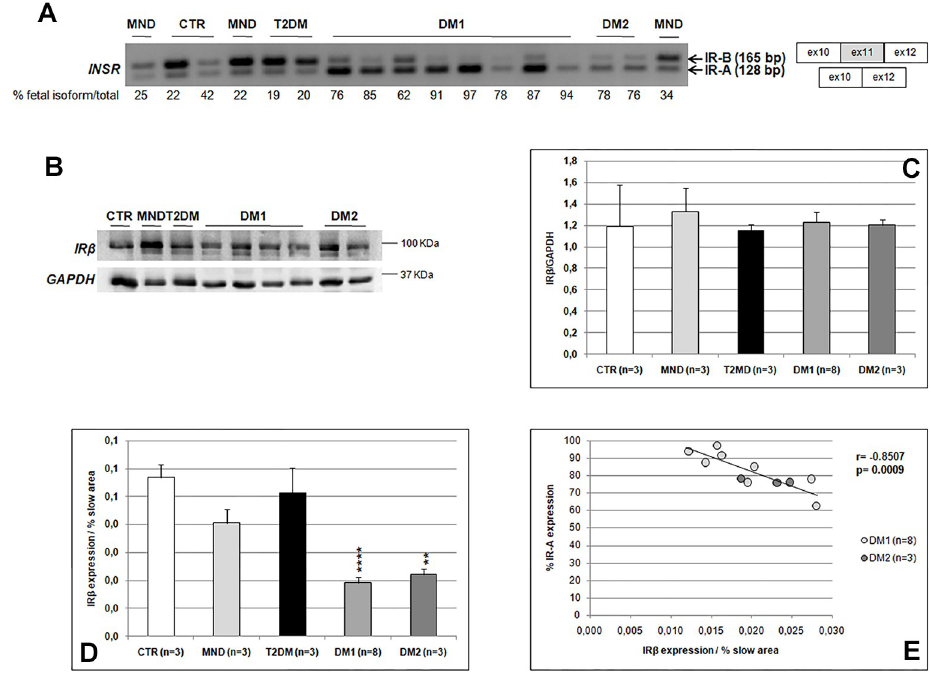
Fig 2. Insulin Receptor alternative splicing and protein expression. (A) INSR splicing products obtained by RT-PCR amplification of RNA isolated from skeletal muscle biopsies. Bands were quantified and proportions of fetal isoform IR-A (-exon 11) were calculated. (B) Representative western blot analysis of the basal expression of IR in skeletal muscle biopsies. (C) Histograms represent mean values of IR expression and bars represent standard error of the mean (SEM). Density of the bands have been normalized to GAPDH expression. (D) Histograms representing the relative amount of IR expression contributed by type 1 fibers. Density of IR bands has been normalized to the percentage of type 1 fibers area. Bars represent standard error of the mean (SEM). Differences between groups have been evaluated by Student t -test. �� p < 0.01; ���� p < 0.0001. It is of note that in the graphic only the statistical differences between DM1 or DM2 and CTR group are shown. (E) Pearson’s correlation between the percentage of fetal IR-A expression and the relative amount of IR expression contributed by type 1 fibers in DM patients.